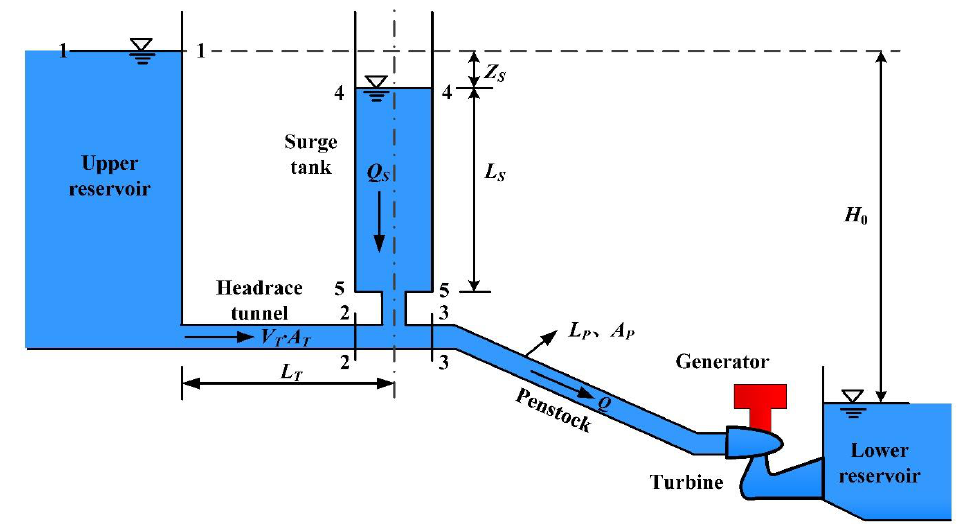
Figure 1. Schematic diagram of a hydropower station with a throttled ST.